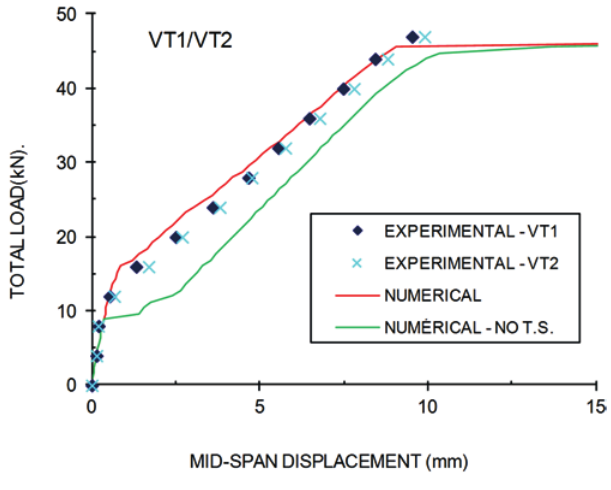
Comparison between numerical (ANEST/CA) and experimental results for beams VT1/VT2 tested by Beber